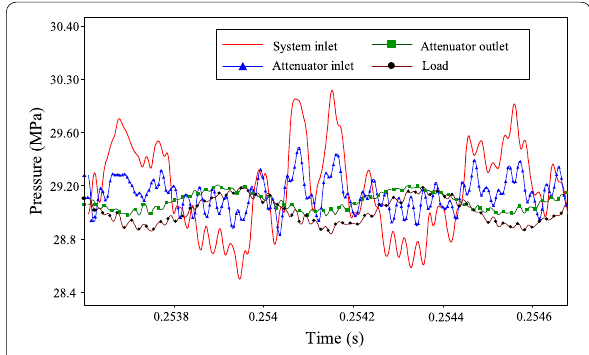
Figure 29 Pressure pulsation curve of the main monitoring points